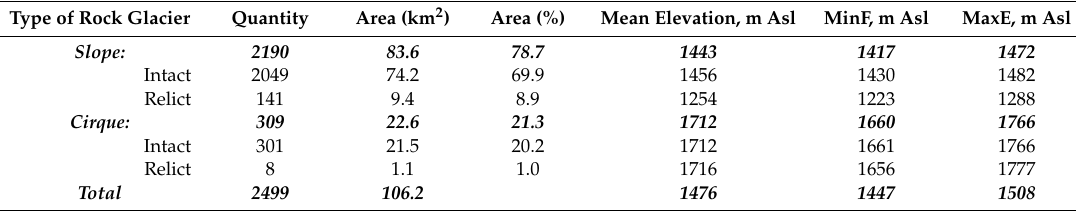
Table 3. Statistics of Rock Glaciers of the Chersky Range.